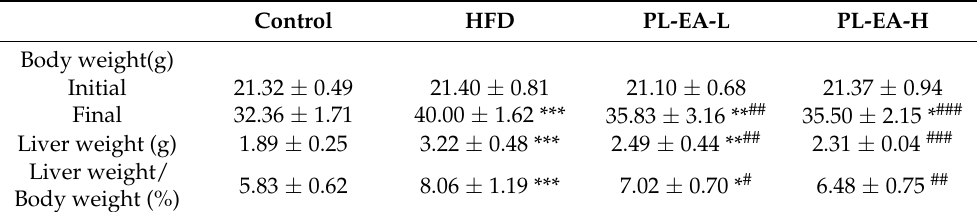
Table 2. Effects of ethyl acetate fraction from 75% methanol extracts of Phellinus linteus mycelium freeze-dried powder (PL-EA) on body weight; liver weight and liver to body weight ratio in a high-fat/high-fructose diet (HFD)-fed mouse model.